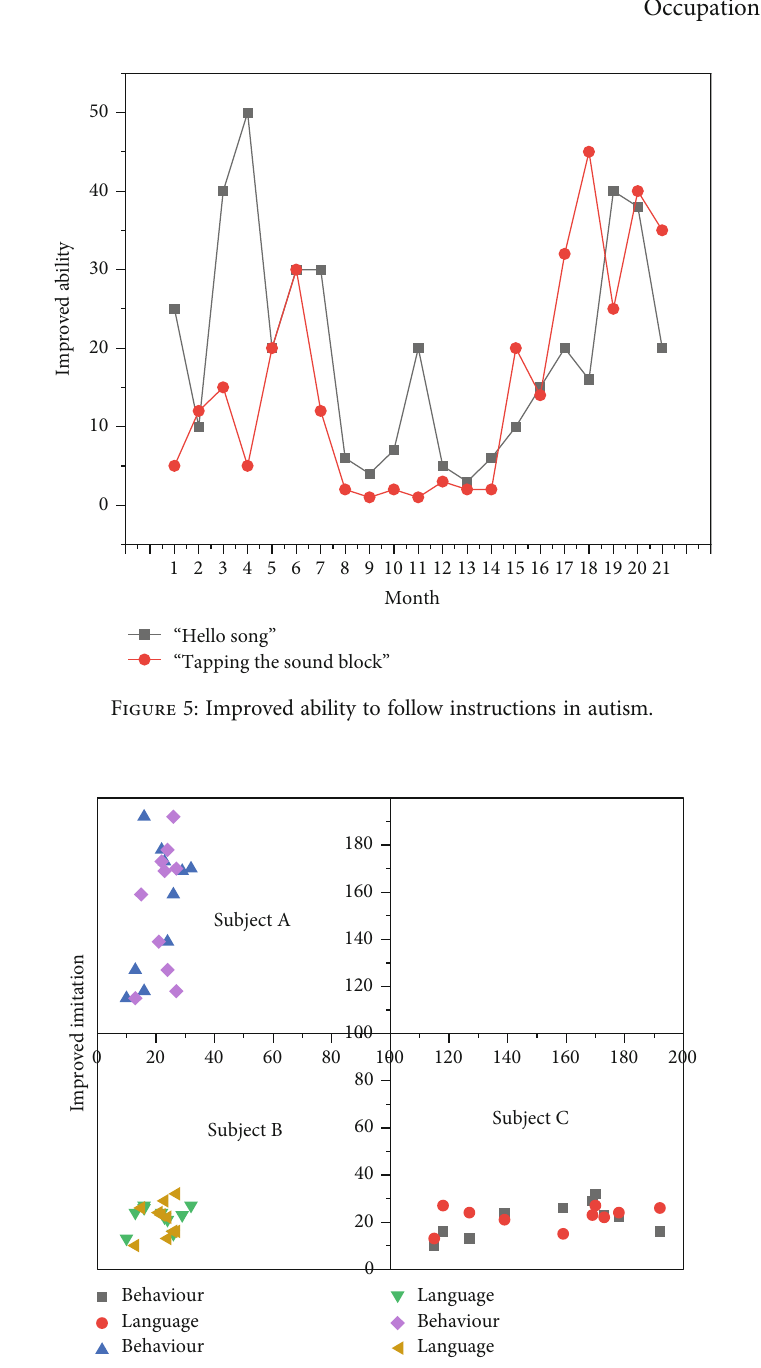
Figure 6: Improved motor imitation in